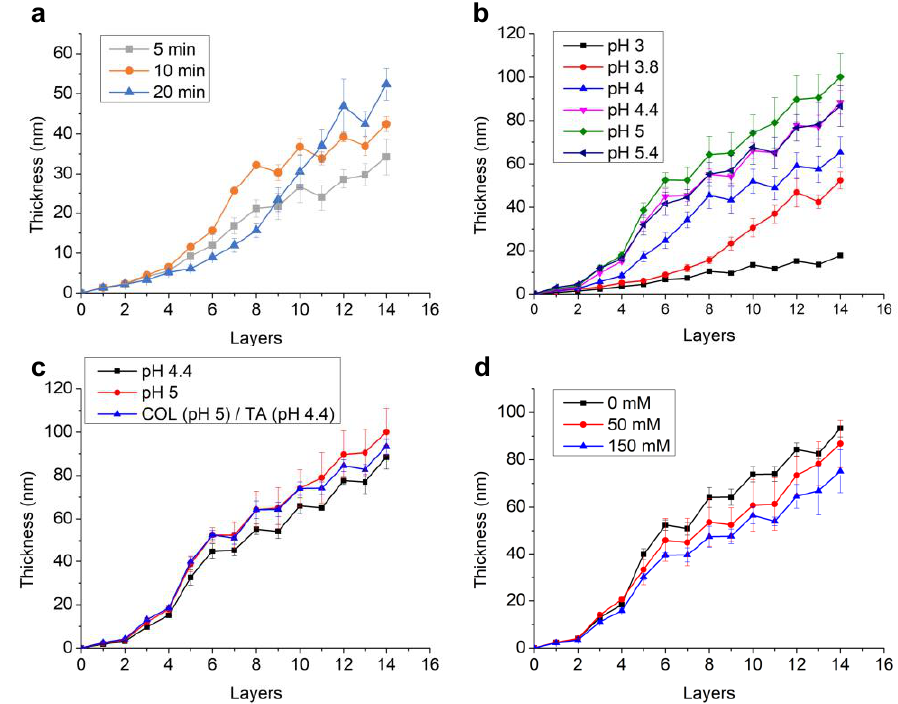
Figure 1. Buildup of COL/TA LbL films: evolution of (COL/TA) 7 film thickness measured by ellipsometry ( a ) at pH 3.8 with different dipping times, ( b , c ) at different pH values with a dipping time of 20 min, and ( d ) with COL at pH 5 and TA at pH 4.4 at different NaCl concentrations with a dipping time of 20 min. The deposition of TA and COL corresponds to even and odd numbers, respectively. Mean and standard deviation values were determined from the thickness of three different samples, with this thickness being the average of 10 values from 10 different areas of the sample.